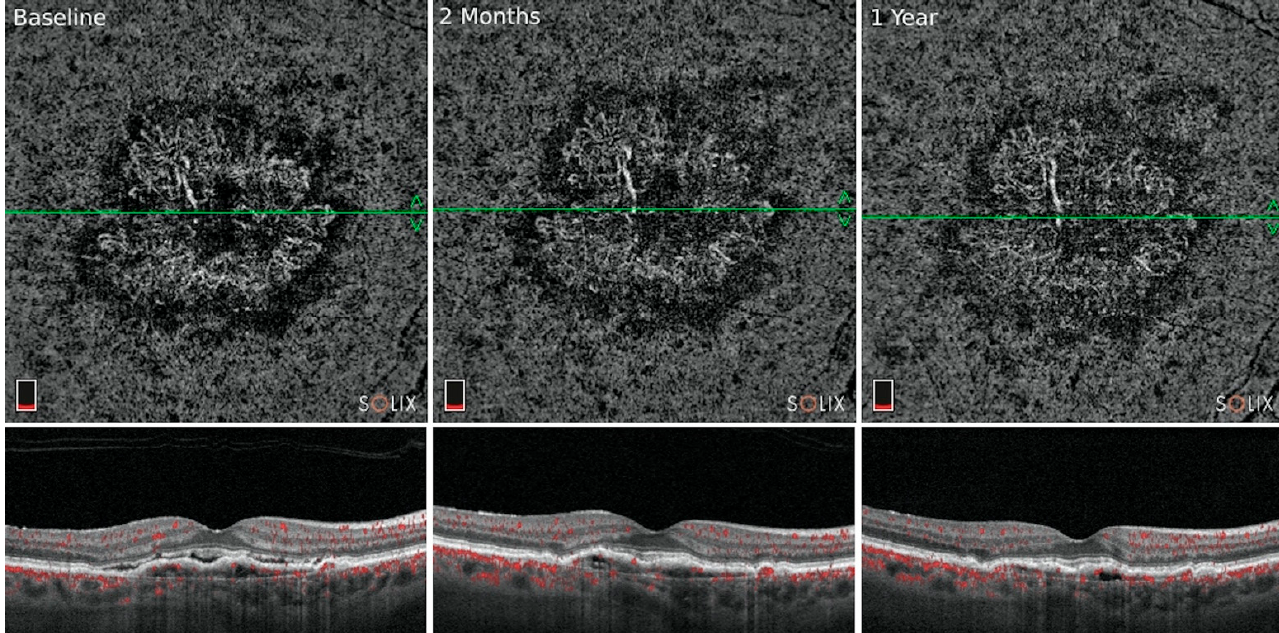
Figure 3. Growth of macular neovascularization after anti-VEGF therapy: En face choriocapillaris OCTA and structural OCT B-scan images of mature type 1 macular neovascularization (MNV). This patient with neovascular age-related macular degeneration (AMD) in the right eye received anti-VEGF injections every 8 to 12 weeks for several years. Note the OCTA characteristics of mature MNV that include larger thick vessels associated with a secondary dense fine capillary ramification. A prominent perilesional halo is also identified with all three lesions. Even with continued anti-VEGF injections, the mature network shows mild growth in total area from the baseline visit ( left ) to the one-year follow-up ( right ) visit. While anti-VEGF treatment reduces fine capillary lesions at the border in the short term, lesions typically grow in overall area after 1 year.